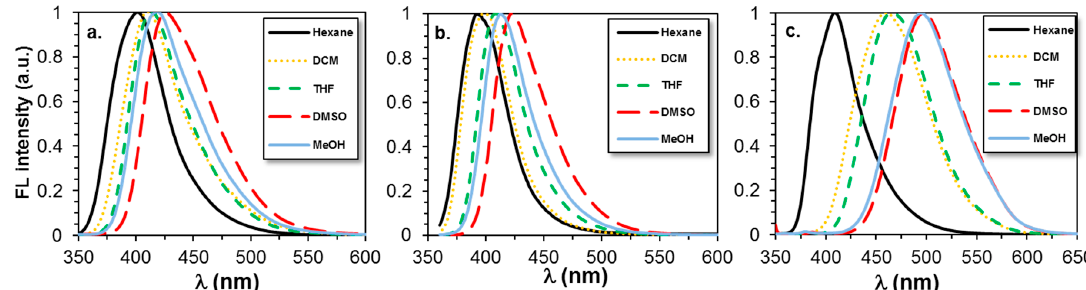
Figure 3. Normalized fluorescence emission spectra of the 1,4-ICAN ( a ), 2,6-ICAN ( b ), and 1,5-ICAN ( c ) isomers recorded in different solvents. Table 2. The fluorescence emission maxima ( λ Em ) and the quantum yields ( Φ f ) determined in various solvents for the 1,5-ICAN, 1,4-ICAN, and 2,6-ICAN isomers. 1,5-ICAN